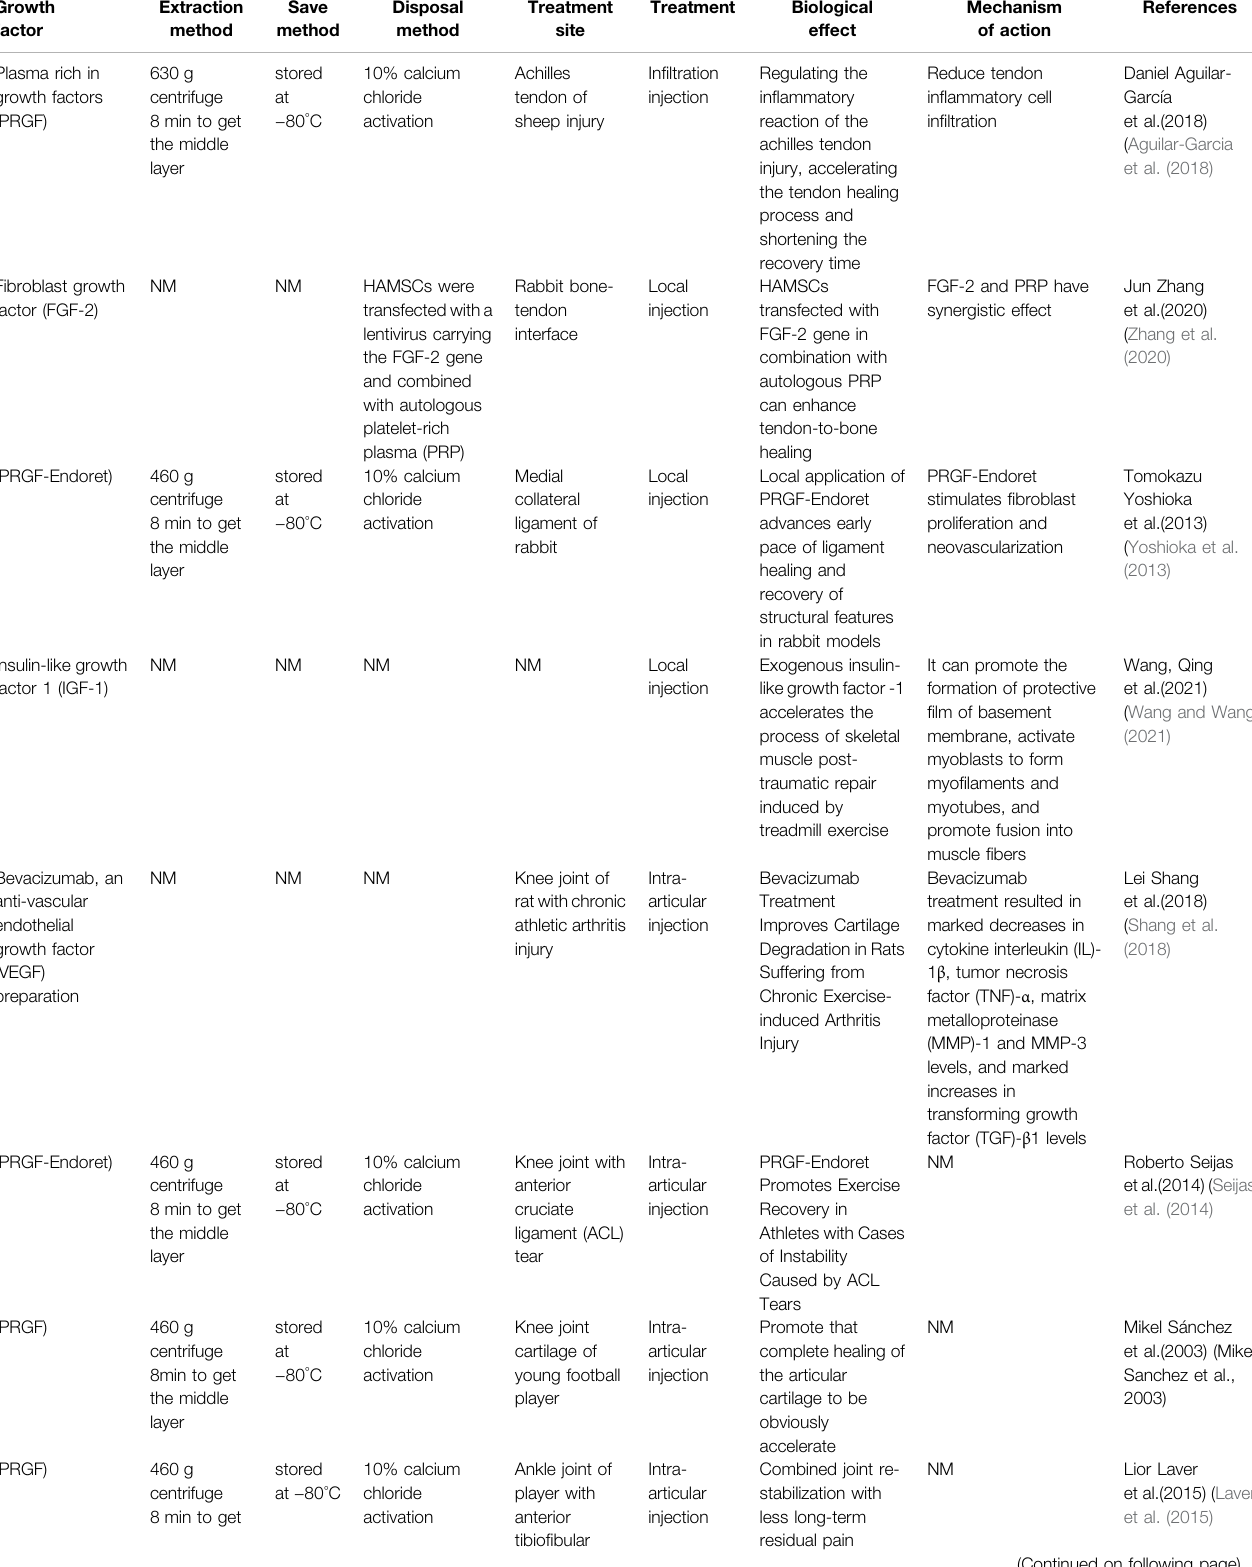
TABLE 1 | Therapeutic use of growth factor